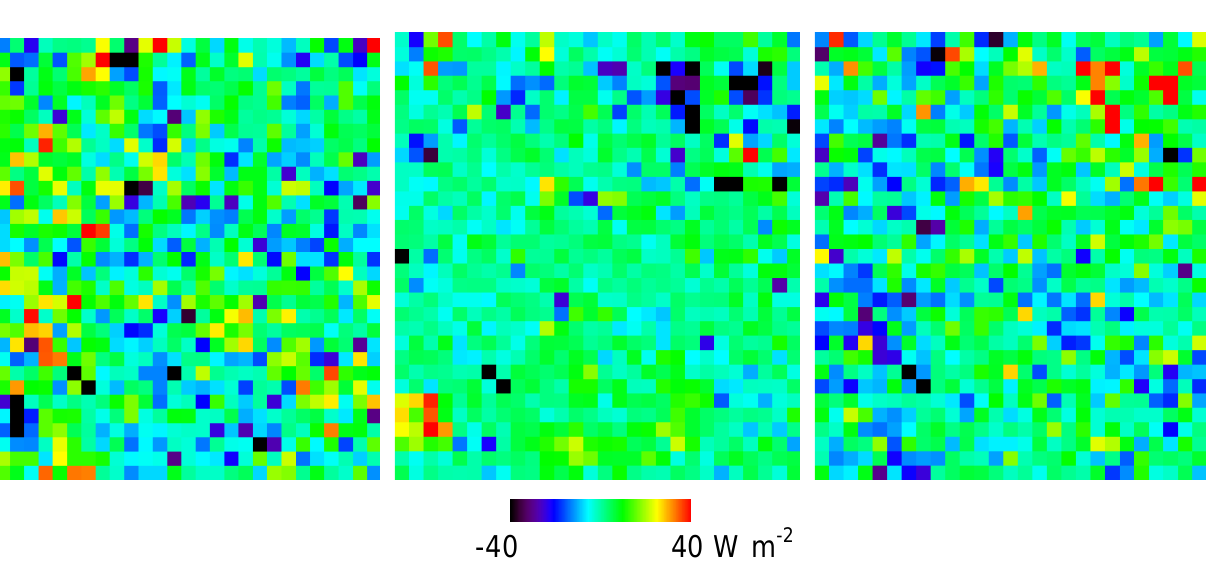
Figure 6. Heat flux differences between the results derived from ASTER and Formosat-2 in a part of the urban area: (a) sensible heat H , (b) latent heat LE , and (c) storage heat flux D G